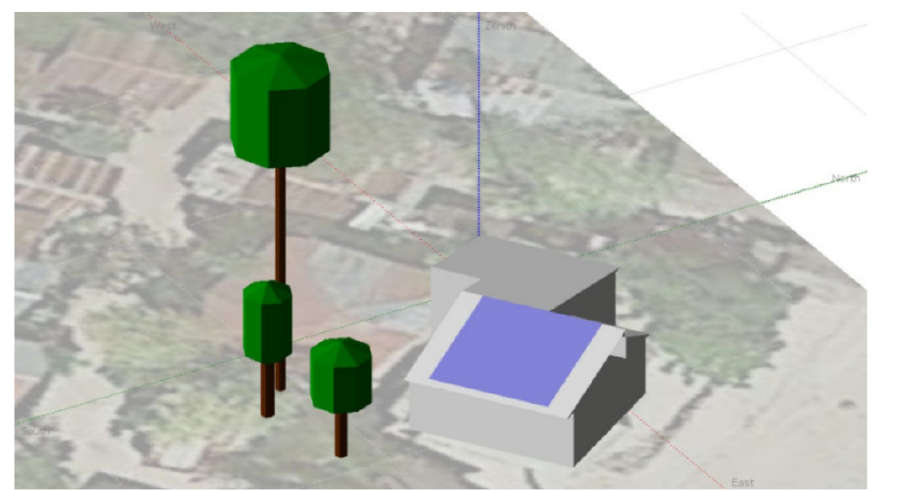
Figure 9. Near-shading 3D simulation scene in PVsyst for the southeast roof face of structure